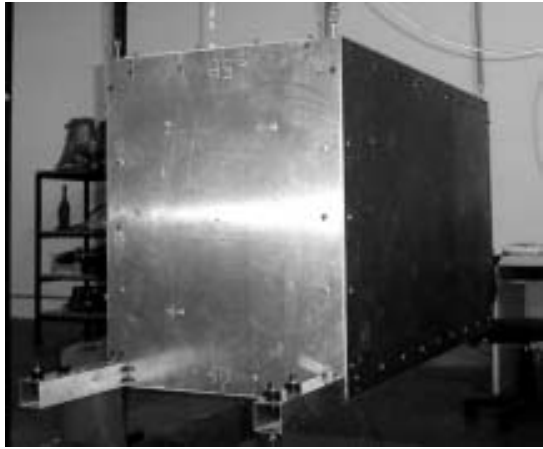
Fig. 1. The test structure